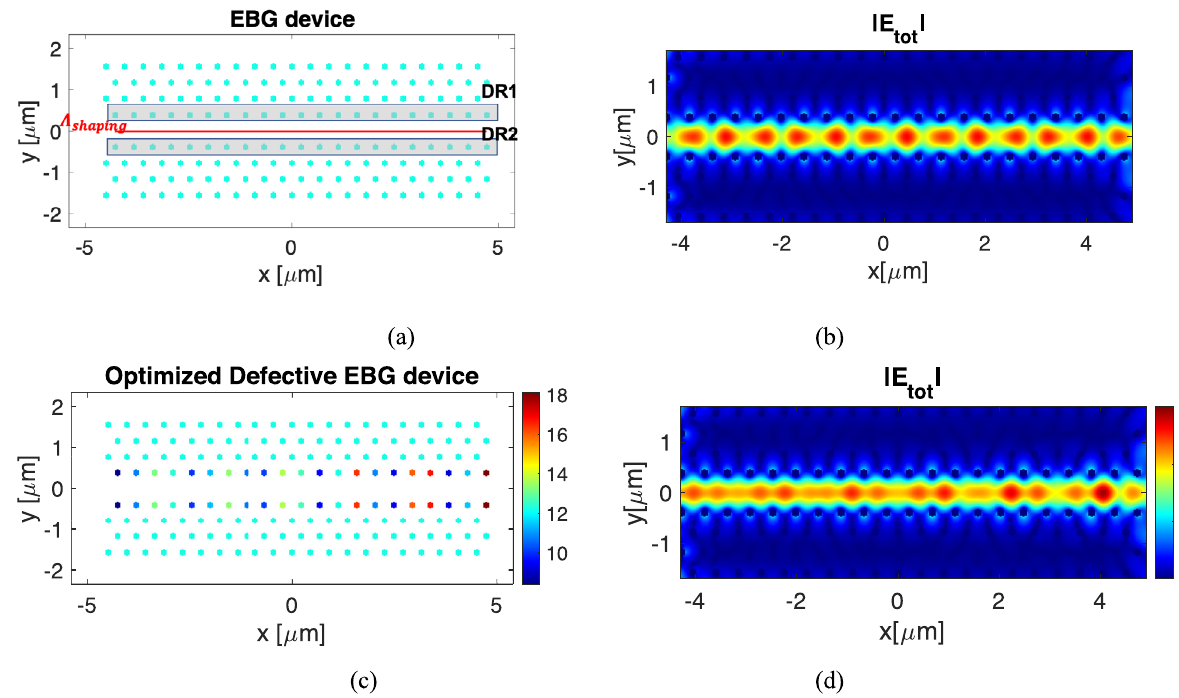
Fig. 3. Optimization of a straight waveguide. (a) Permittivity map of the defective EBG device where the DR is superimposed with light grey rectangle and (b) the corresponding electric fi eld amplitude distribution. (c) and (d) the same as (a) and (b) but for the optimized EBG device through the I-SMM [ e opt